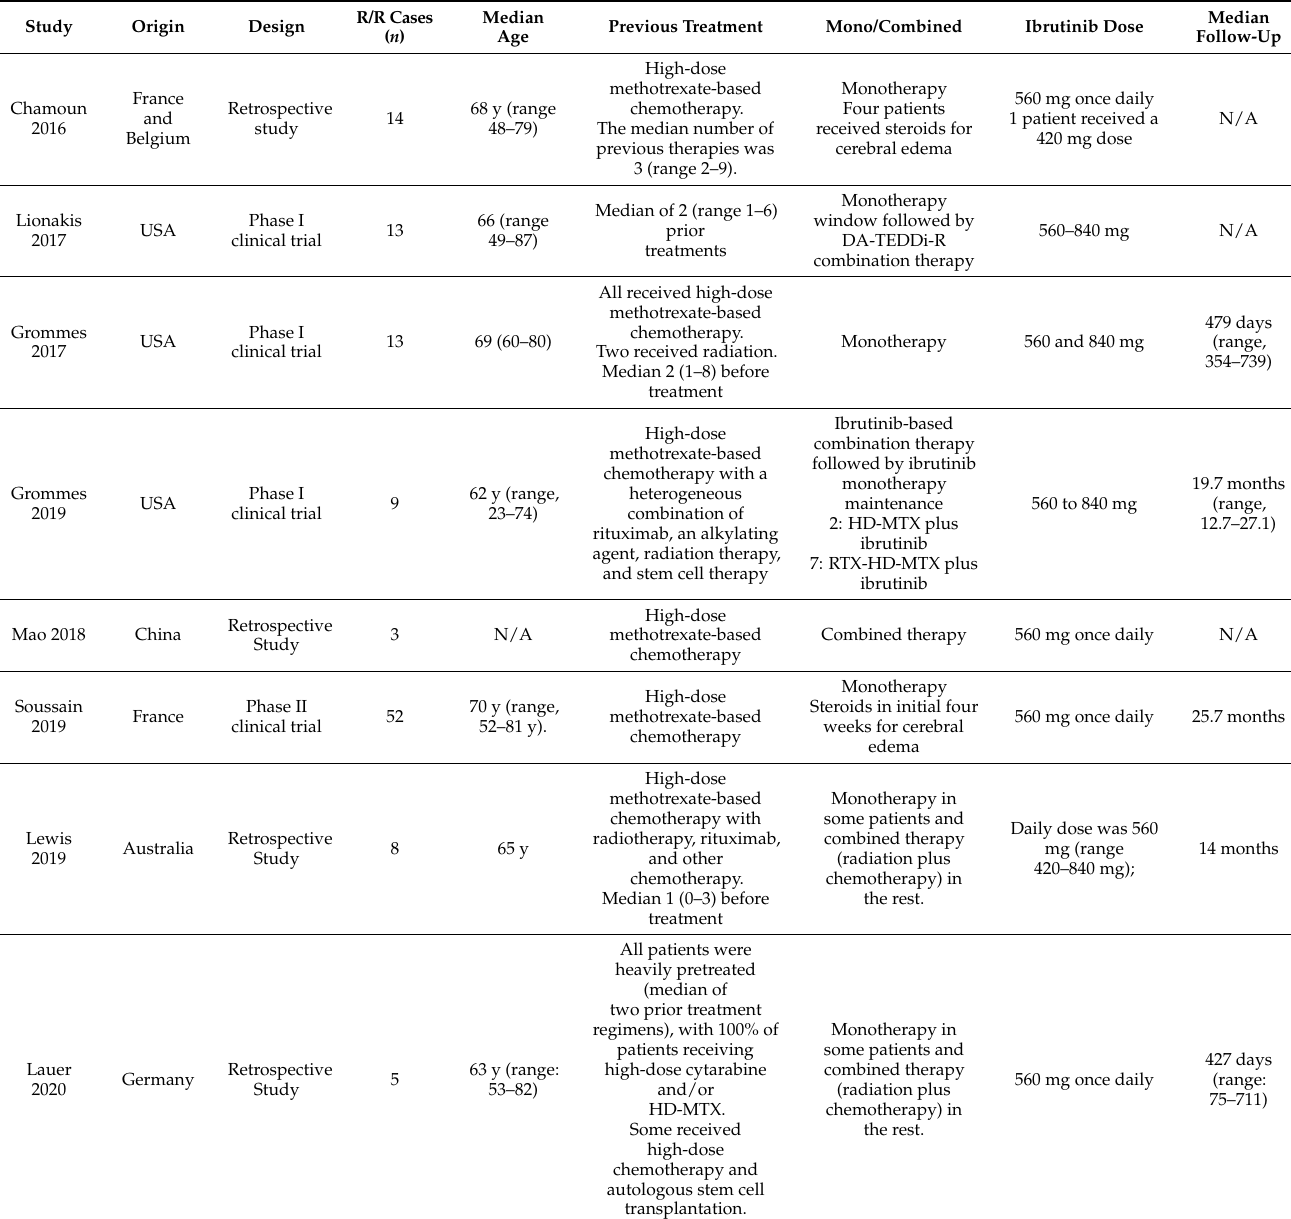
Table 1. Key methodological characteristics of the included